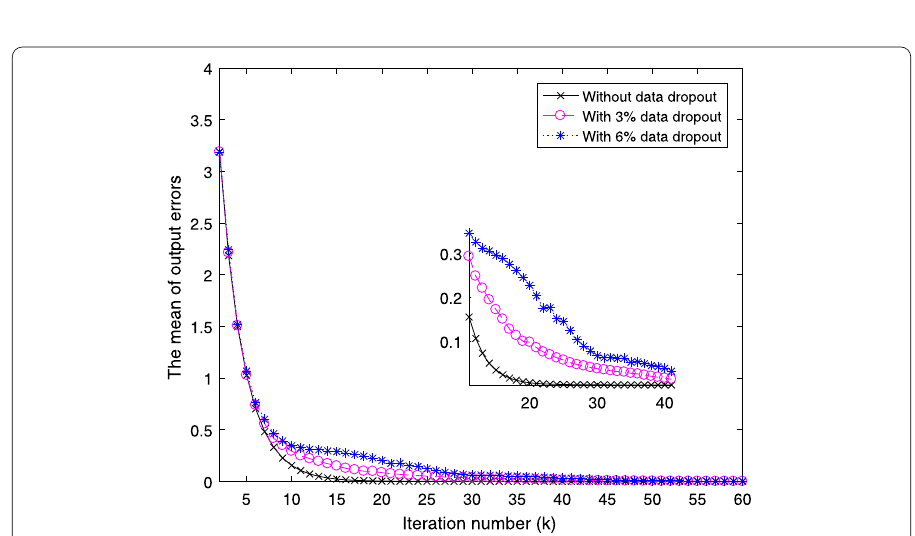
Figure 4 The mean of output errors compensated in iteration